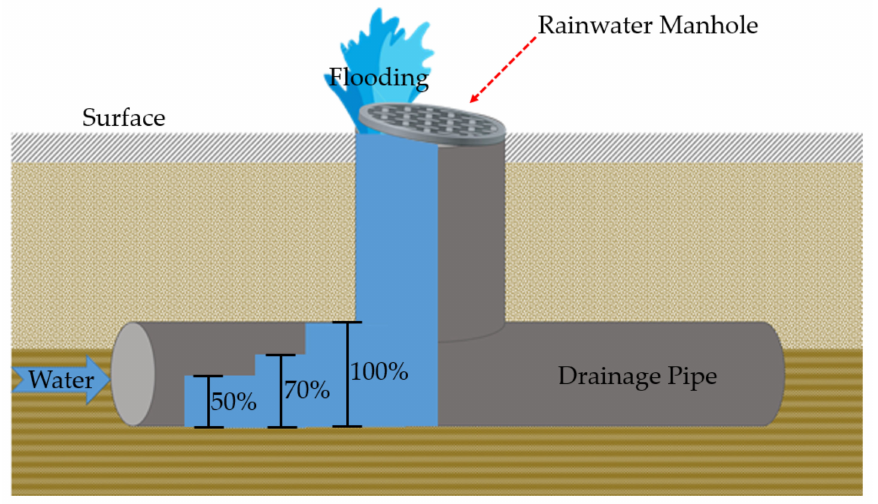
Figure 2. Schematic of the four